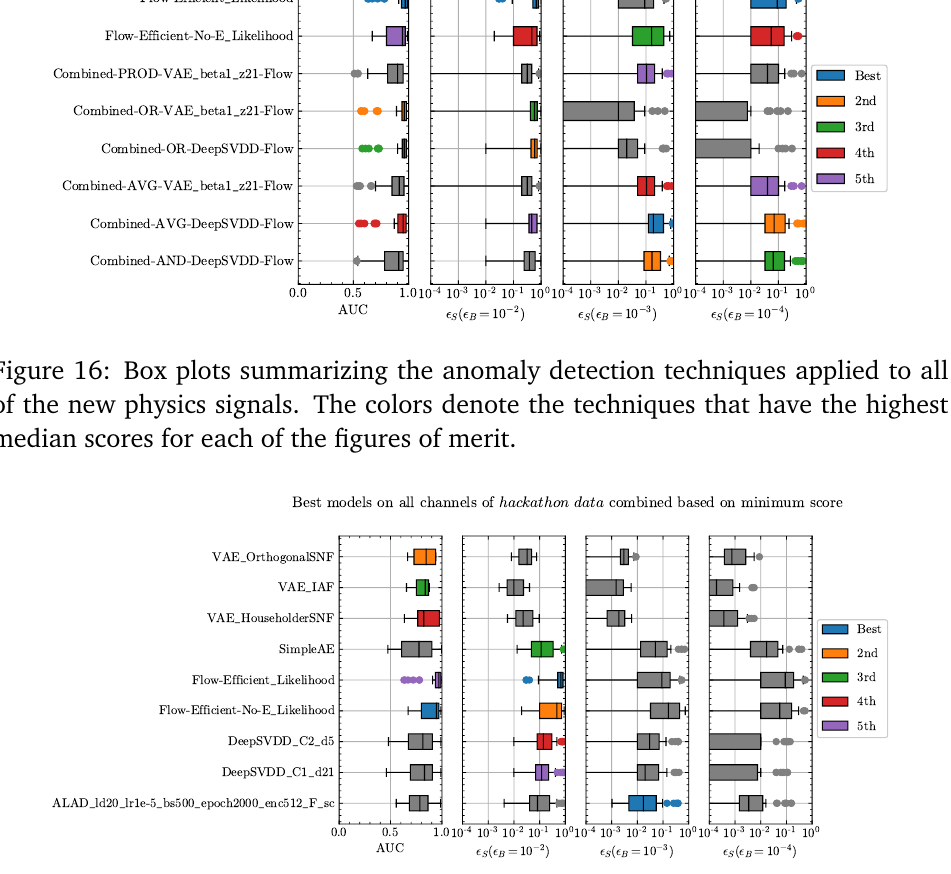
above 0 for S above 0 for all S